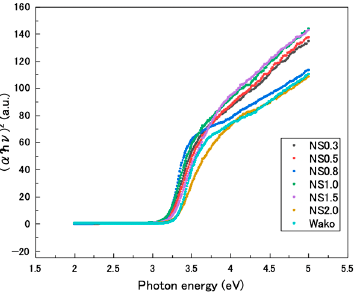
Figure 3. Tauc plots of TiO 2 nanosheet and TiO 2 nanoparticle samples. Table 1. Optical band gaps of various TiO 2 samples.